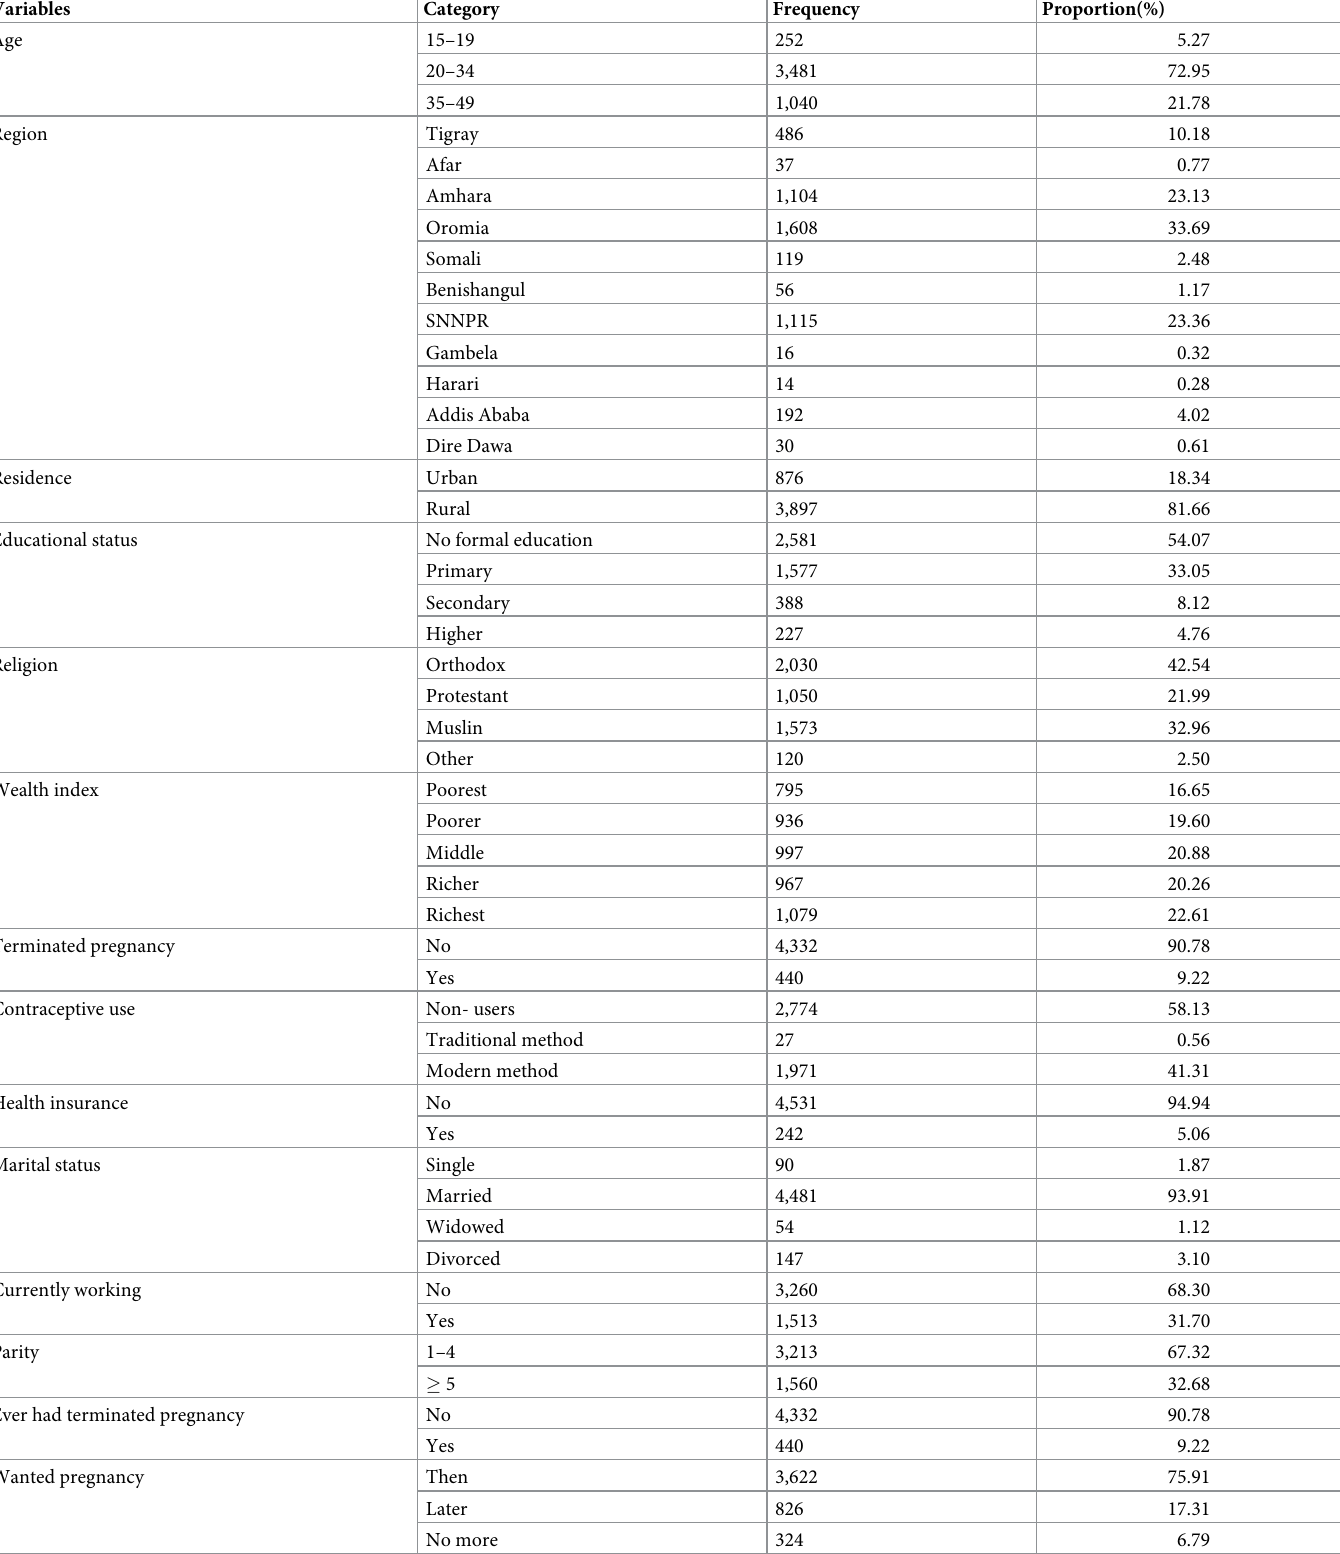
Table 1. Background characteristics of reproductive aged women in Ethiopia, 2016